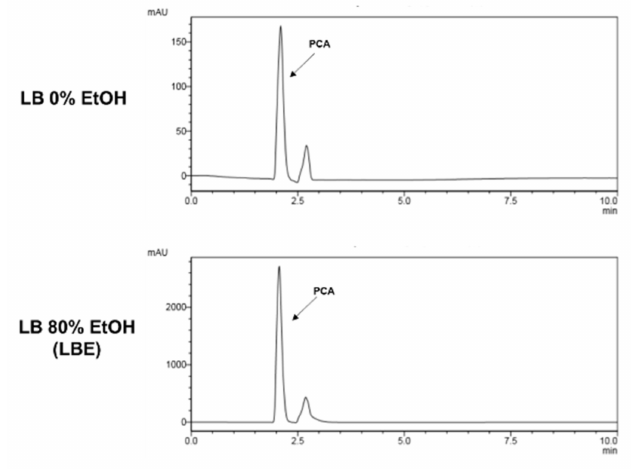
Figure 4. High-performance liquid chromatography (HPLC) chromatogram of protocatechuic acid (PCA) in LBE.